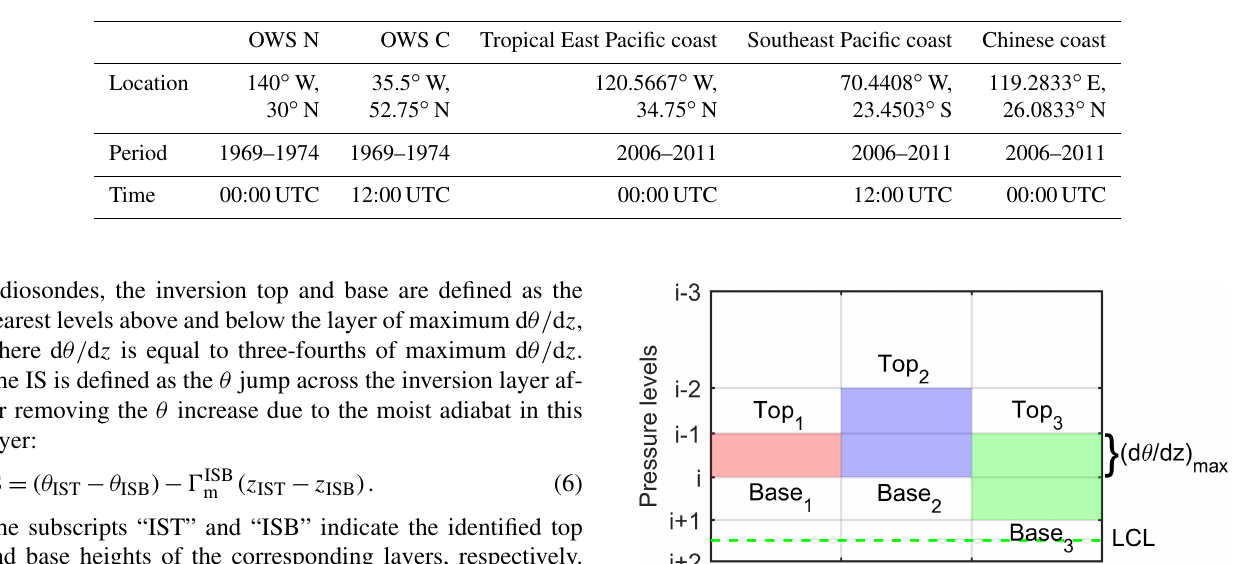
Table 1. The location, observational period and time of the IGRA radiosonde stations.